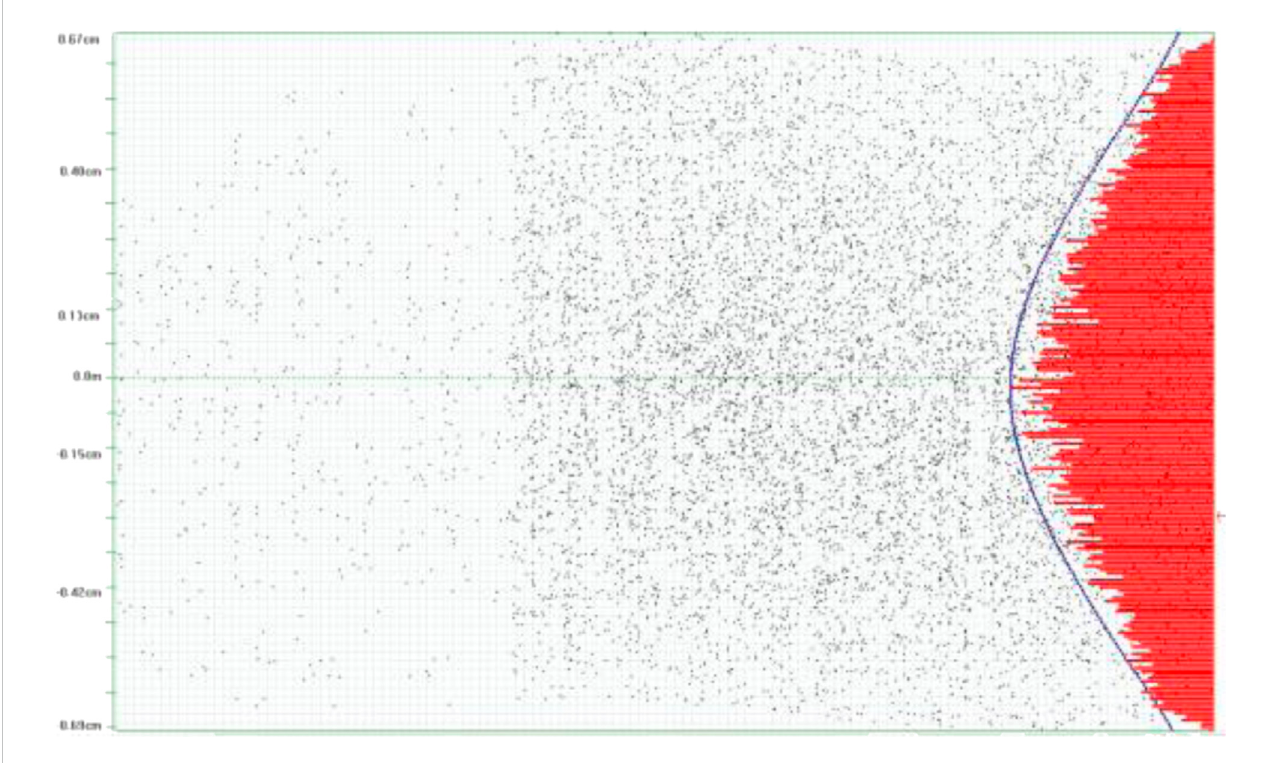
FIGURE 3 Plot of residuals from polynomial fi t of measurement